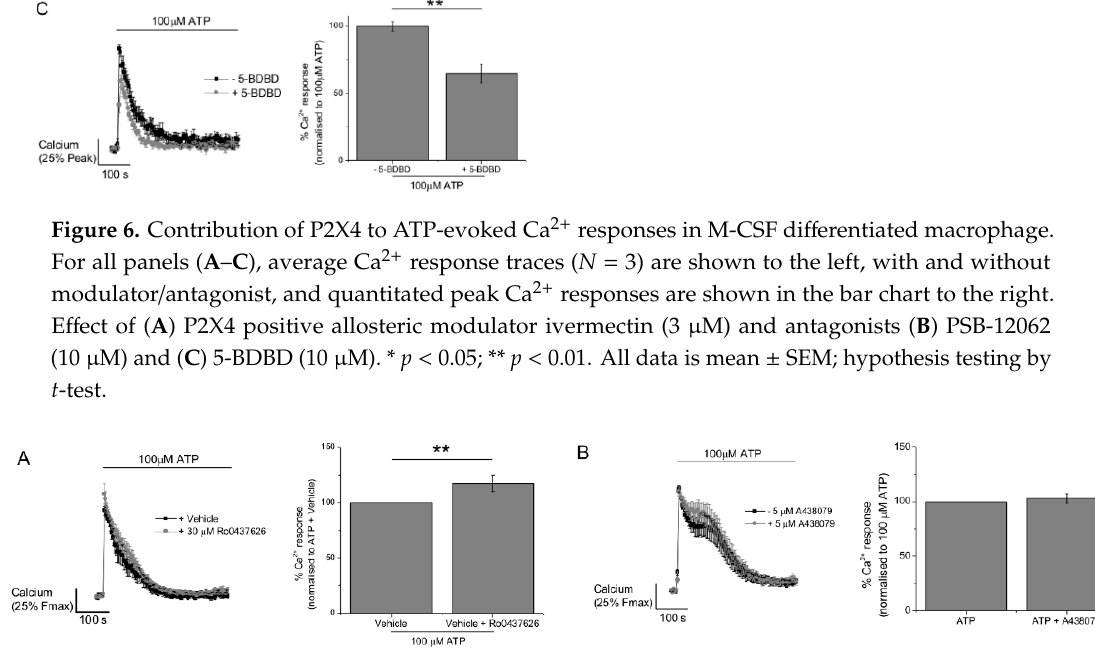
Figure 7. Lack of inhibitory effect of P2X1 and P2X7 receptor antagonists on responses activated by maximal ATP concentrations. For panels A and B , average Ca 2+ response traces ( N = 3) are shown to the left, with and without modulator/antagonist, and quantitated peak Ca 2+ responses are shown in the bar chart to the right. Effect of ( A ) P2X1 receptor antagonism (Ro0437626, 30 μ M) and ( B ) P2X7 receptor antagonism (A438079, 5 μ M). ** p < 0.01. All data is mean ± SEM; hypothesis testing by t -test.